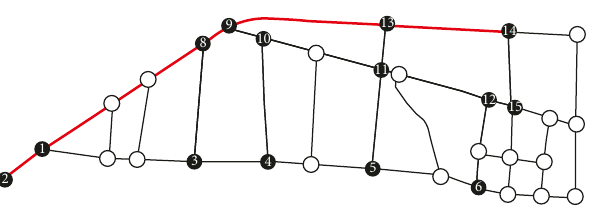
Figure 6: Short distance path a.